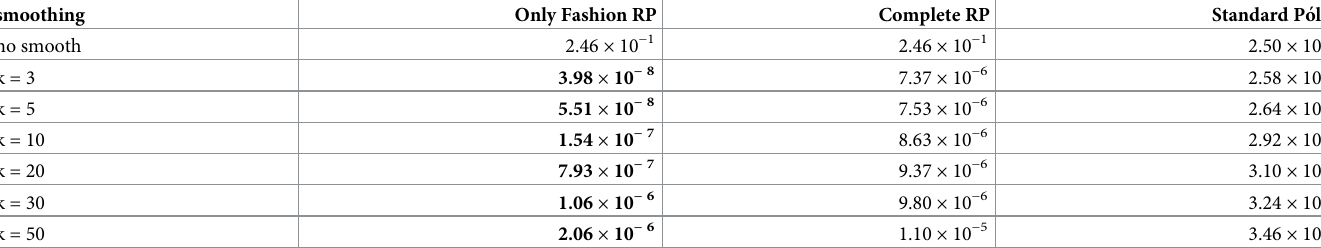
Table 11. “Covid” ( T = 0.35, entire, D = 3 0 , S = 1000 slots of equal size): MSE for different levels of smoothing. smoothing Only Fashion RP